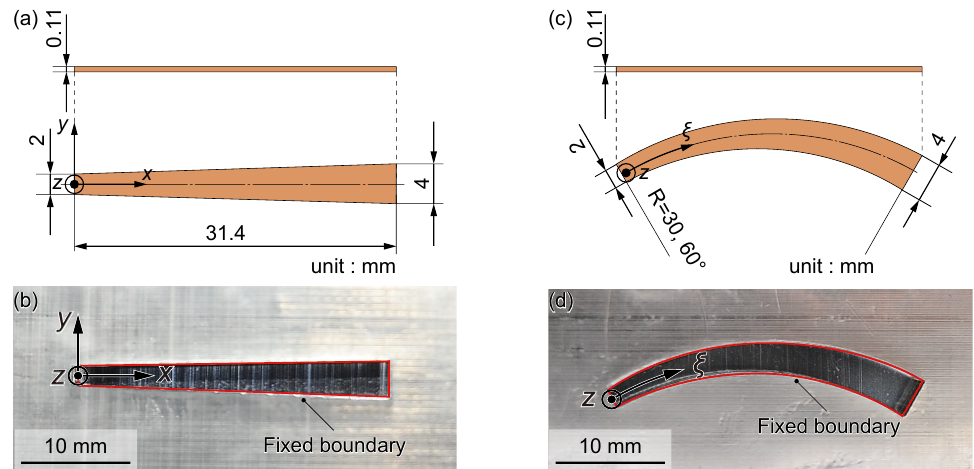
Figure 1. In vitro experiment using the prototype devices of an artificial cochlear sensory epithe- lium. Trapezoidal and curved membrane devices were fabricated to examine the effect of a curved device on the oscillation characteristics. ( a ) Dimensions of a trapezoidal artificial cochlear sensory epithelium and ( b ) photograph. ( c ) Dimensions of a curved artificial cochlear sensory epithelium and ( d ) photograph. A piezoelectric membrane made of PVDF film was used for these prototype devices. Al thin electrodes were deposited on both sides of the PVDF film. The compound membrane was sandwiched between acrylic plates with a trapezoidal or curved shape hole, and fixed boundaries of the prototype devices were determined by the edges of the hole. In the photographs ( b , d ), the red solid lines indicate the fixed boundaries of the devices, silver color the acrylic plate with the trapezoidal or curved shape hole, and black color the Al electrodes deposited on the PVDF